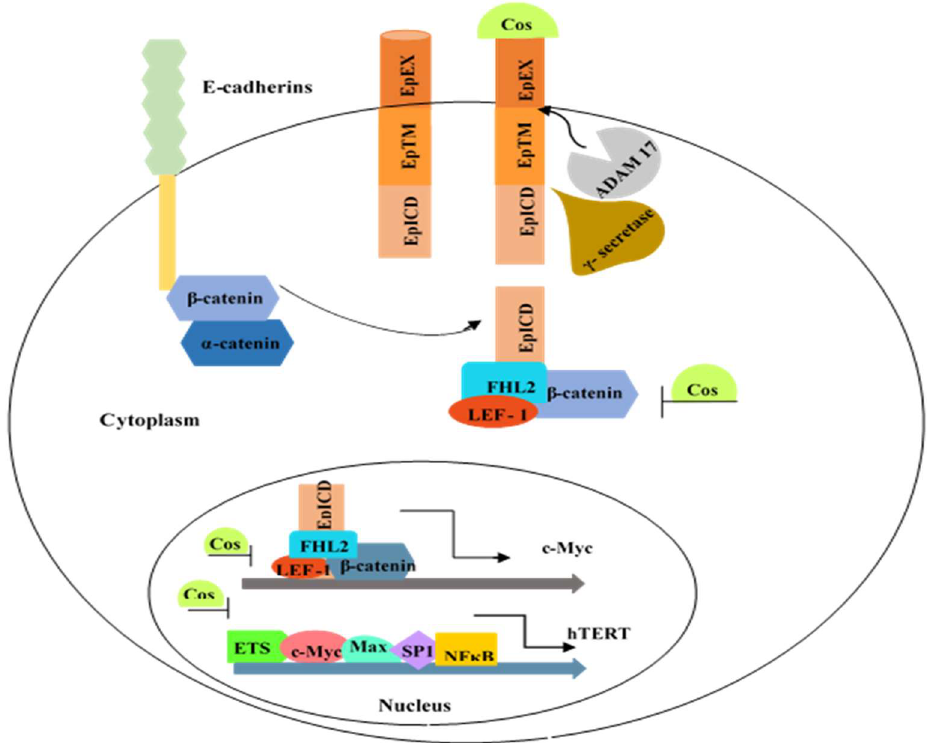
Figure 1. Molecular mechanism of EpCAM and its downstream Myc and TERT genes. Intracellular domain of EpCAM, cleaved by γ -secretase, associates with β -catenin, LEF-1, and FHL2. This complex translocates to the nucleus and regulates Myc transcription. Myc acts as a transcription factor and binds to the TERT promoter. EpEX = EpCAM extracellular domain, EpICD = EpCAM intracellular domain, TM = transmembrane domain.